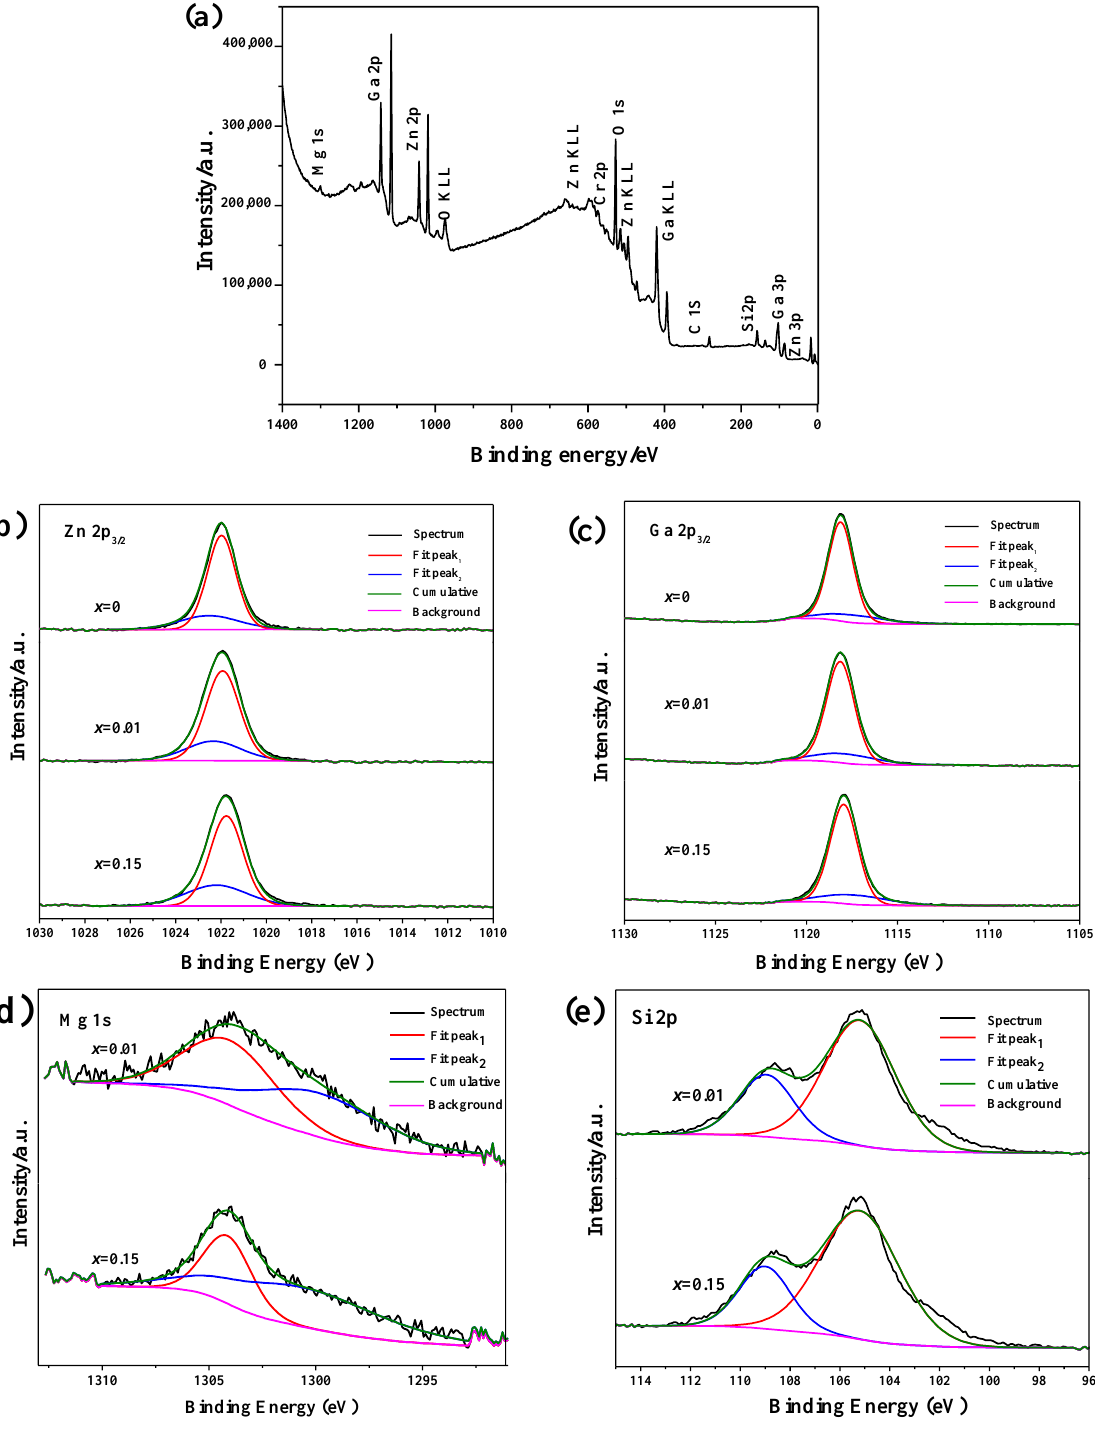
Figure 4. ( a ) XPS survey spectrum of ZGMSO:Cr 3+ ( x = 0.05 sample) and ( b – e ) high-resolution XPS spectra of ZGMSO:Cr 3+ ( x = 0 – 0.15): ( b ) Zn 2p 3/2 , ( c ) Ga 2p 3/2 , ( d ) Mg 1s, ( e ) Si 2p. Raman spectra of ZGMSO:Cr 3+ ( x = 0 – 0.15) are exhibited in Figure 5. For the spinel structure, group theory predicts the following phonon modes, Γ = A 1g + E g + T 1g + 3T 2g + 2A 2u + 2E u + 5T 1u + 2T 2u [31]. Gorkom et al. [32] reported that the Raman peak at ~714 cm −1 is assigned to A 1g Raman-active modes ( k = 0), while the peak at ~610 cm −1 is assigned to